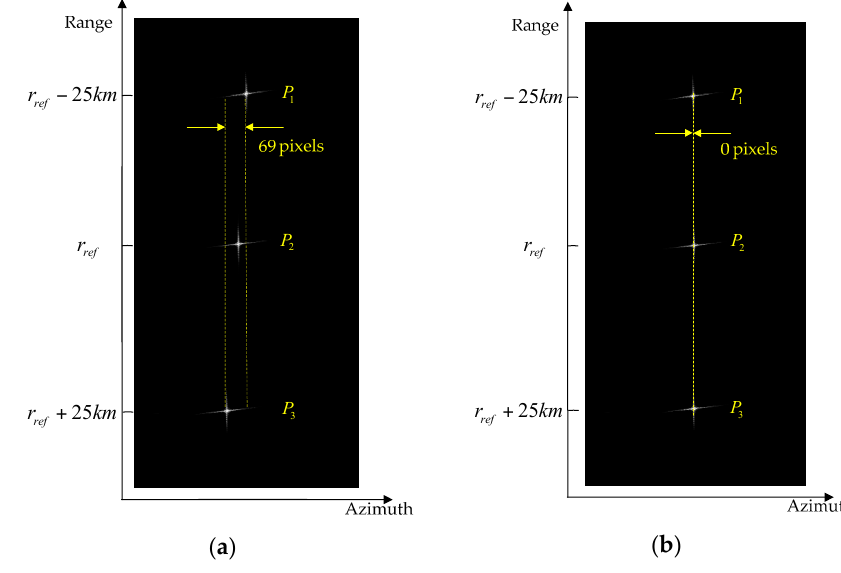
Figure 11. Geometry distortion correction result: ( a ) without correction; ( b ) correction by employing the chirp-z transform.